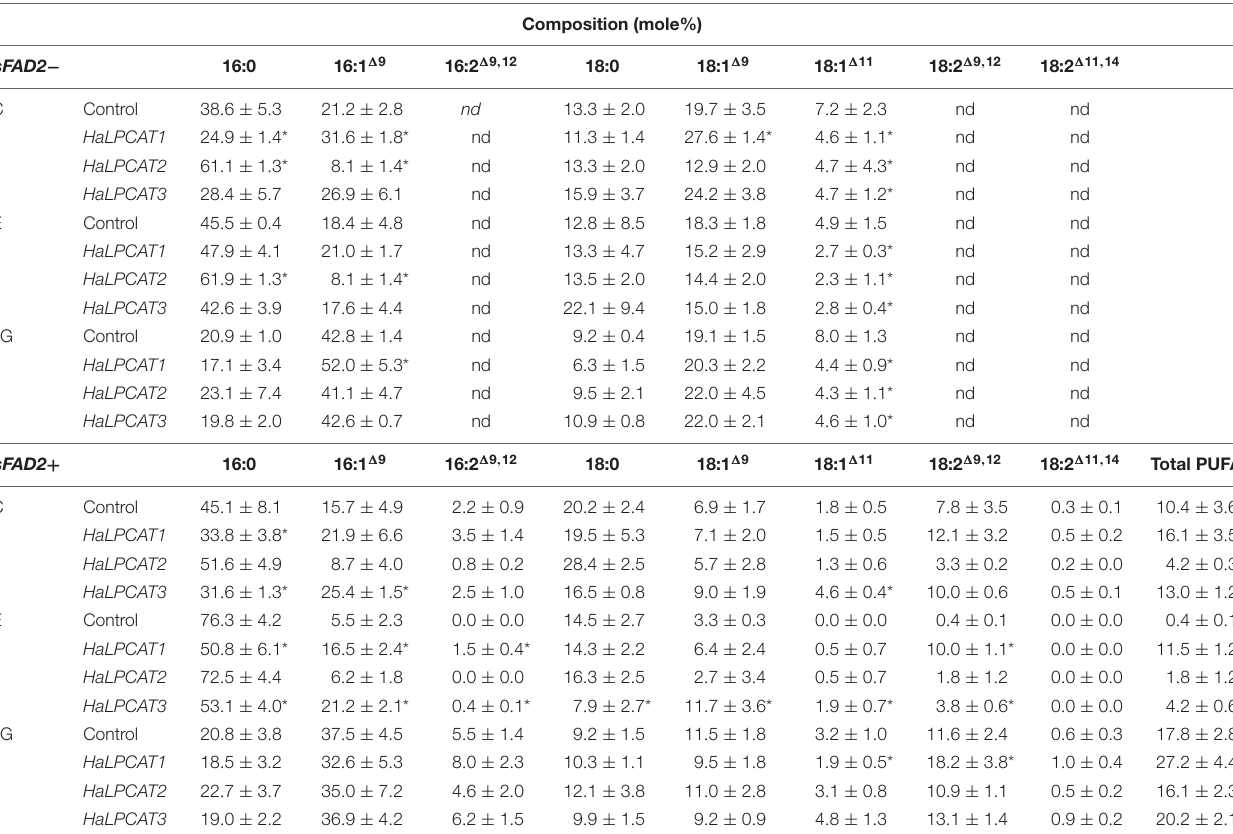
TABLE 2 | Fatty acid composition of triacylglycerols (TAG), phosphatidylethanolamine (PE) and phosphatidylcholine (PC) from Saccharomyces cerevisiae strain Y02431 ( slc4 (cid:49) ) expressing LPCATs from sunflower in the presence or absence of expression of Camelina sativa FATTY ACID DESATURASE 2 ( CsFAD2 ).